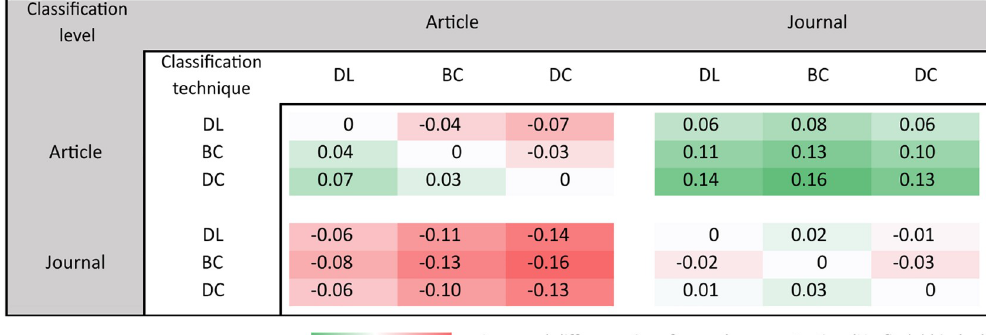
Fig 4. Article-level averaged differences between Herfindahl indexes of papers. The scores in rows are subtracted from those in columns, each time involving scores computed on all 379,413 papers having more than 100 matched references. A green cell indicates that the technique listed in the row yielded greater concentration than the technique listed in the column, and a red cell indicates the opposite.